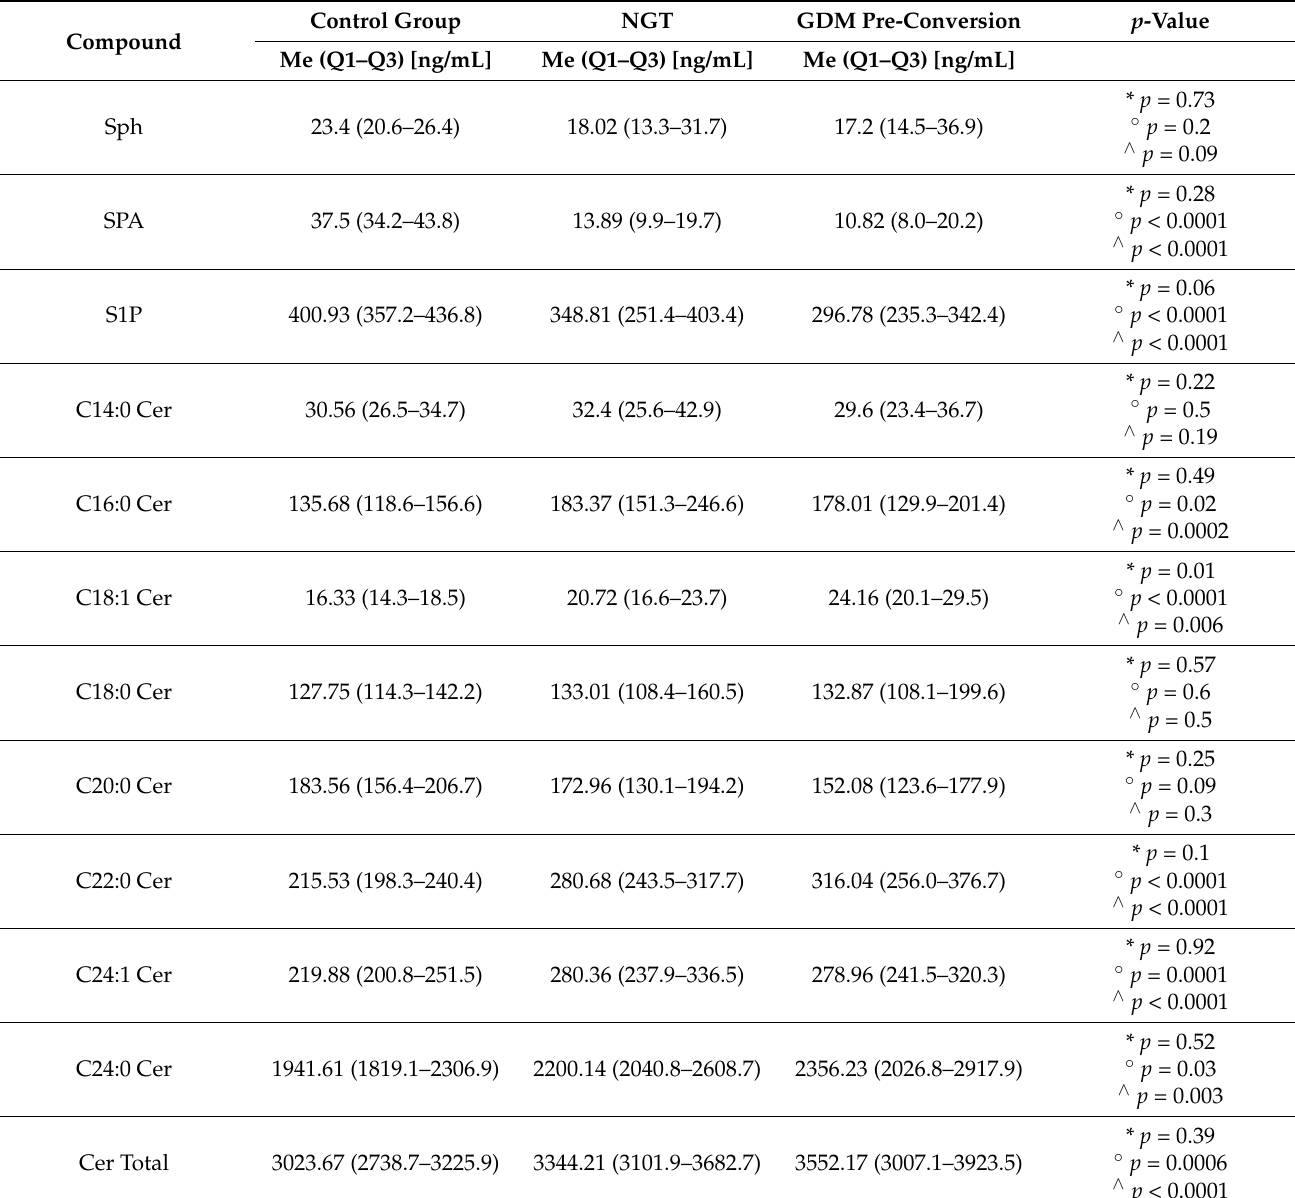
Table 3. The concentration of sphingolipids in the serum of patients in the non-pregnant control group and pregnant GDM pre-conversion and NGT group in their 1st